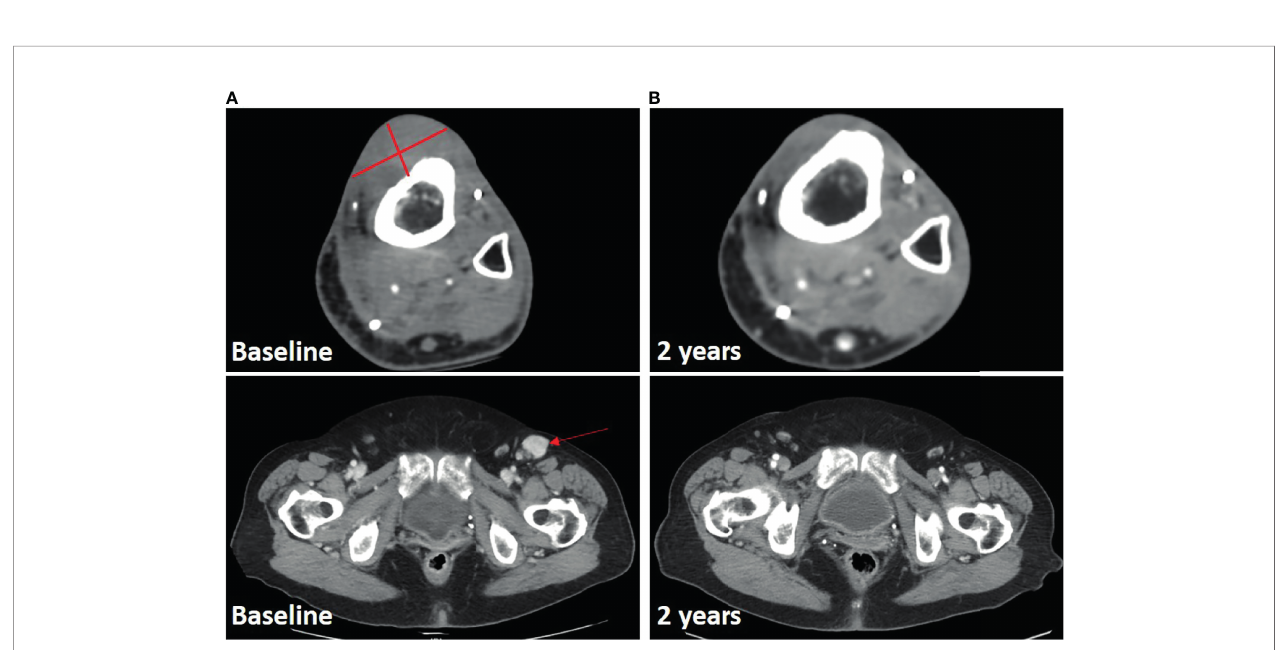
FIGURE 2 | Response in Case 2 treated with ILI and pembrolizumab. (A) , Baseline CT scan with lesions noted. (B) , 2-year follow-up scan demonstrating ongoing response both in infused limb and at distant site.